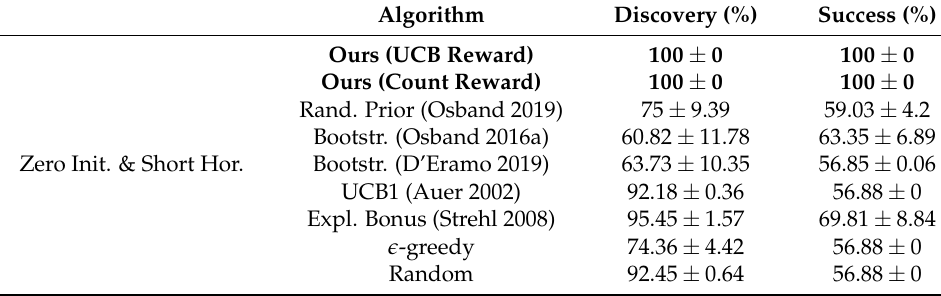
Table A4. Deep gridworld results